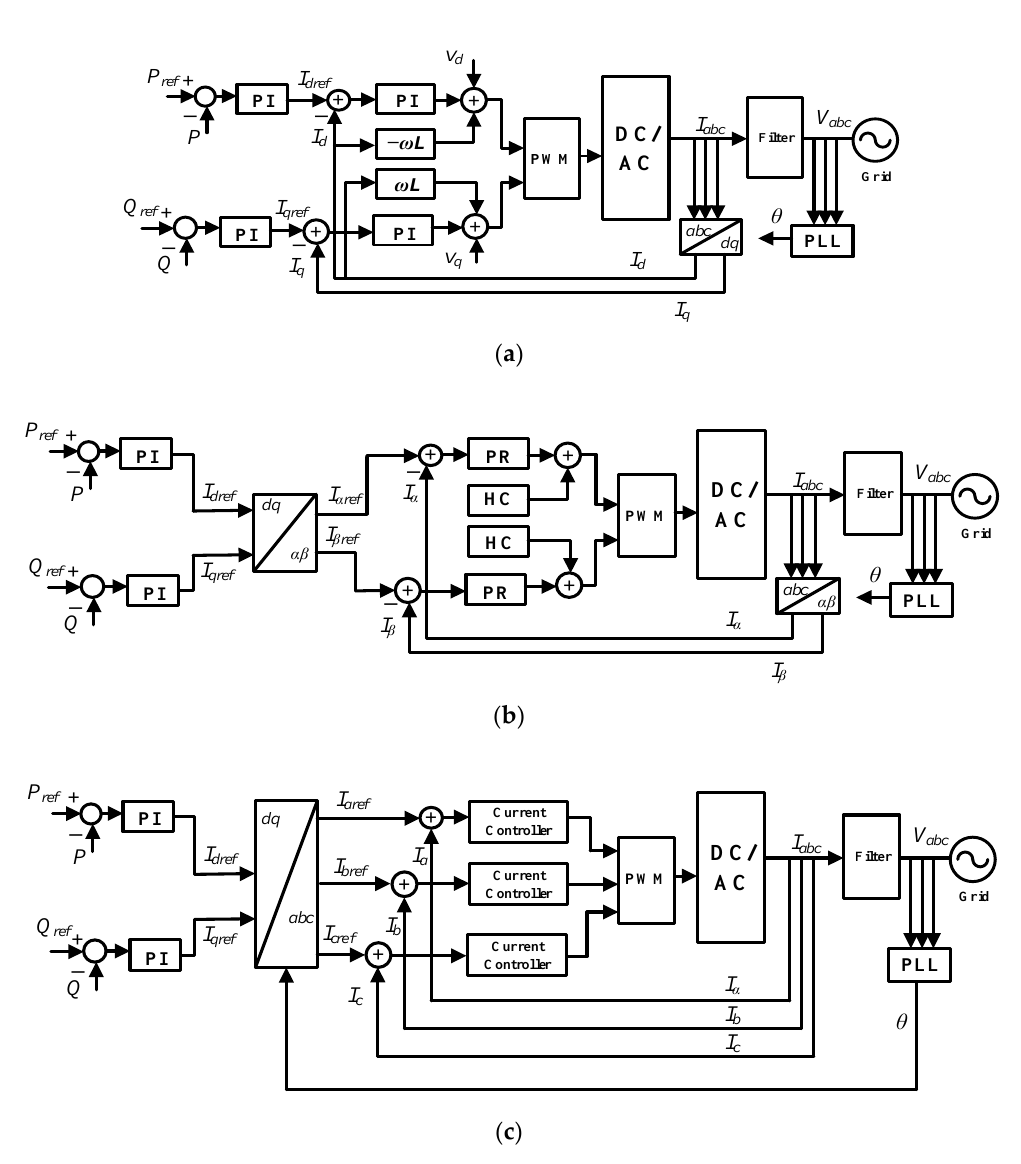
Figure 25. Control structures for three-phase inverters. (a) dq control ; (b) 𝜶𝜷 -control ; (c) abc control .